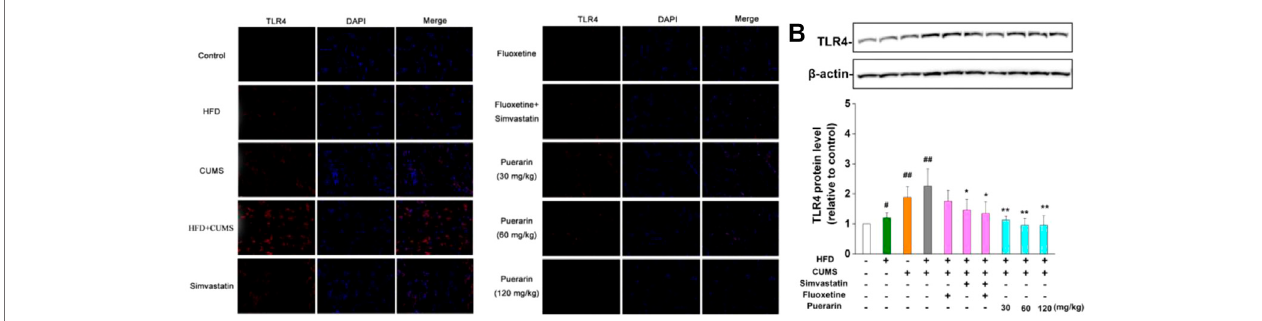
FIGURE5| PuerarindecreasedthelevelofCNSTLR4. (A) PuerarindecreasedthelevelofTLR4intheprefrontalcortexofHFD/CUMS-induceddepression-likerats (400 × magni fi cation).ThelocalizationofTLR4wasdeterminedbyimmuno fl uorescence.TLR4-positivecellswereidenti fi edasred,andthenucleuswasstainedwithDAPI in blue. (B) Puerarin reduced the expression of TLR4 in the hippocampal tissues of HFD/CUMS-induced depression-like rats. The protein expression of TLR4 was detectedbyWesternblotting. β -actinwasusedastheinternalreference.Thedensitometrywasquanti fi edusingImageJsoftware.Valuesareexpressedasmean ± S.E.M ( n (cid:2) 3). # p < 0.05 and ## p < 0.01 vs. the normal control group; * p < 0.05 and ** p < 0.01 vs. the HFD/CUMS group.